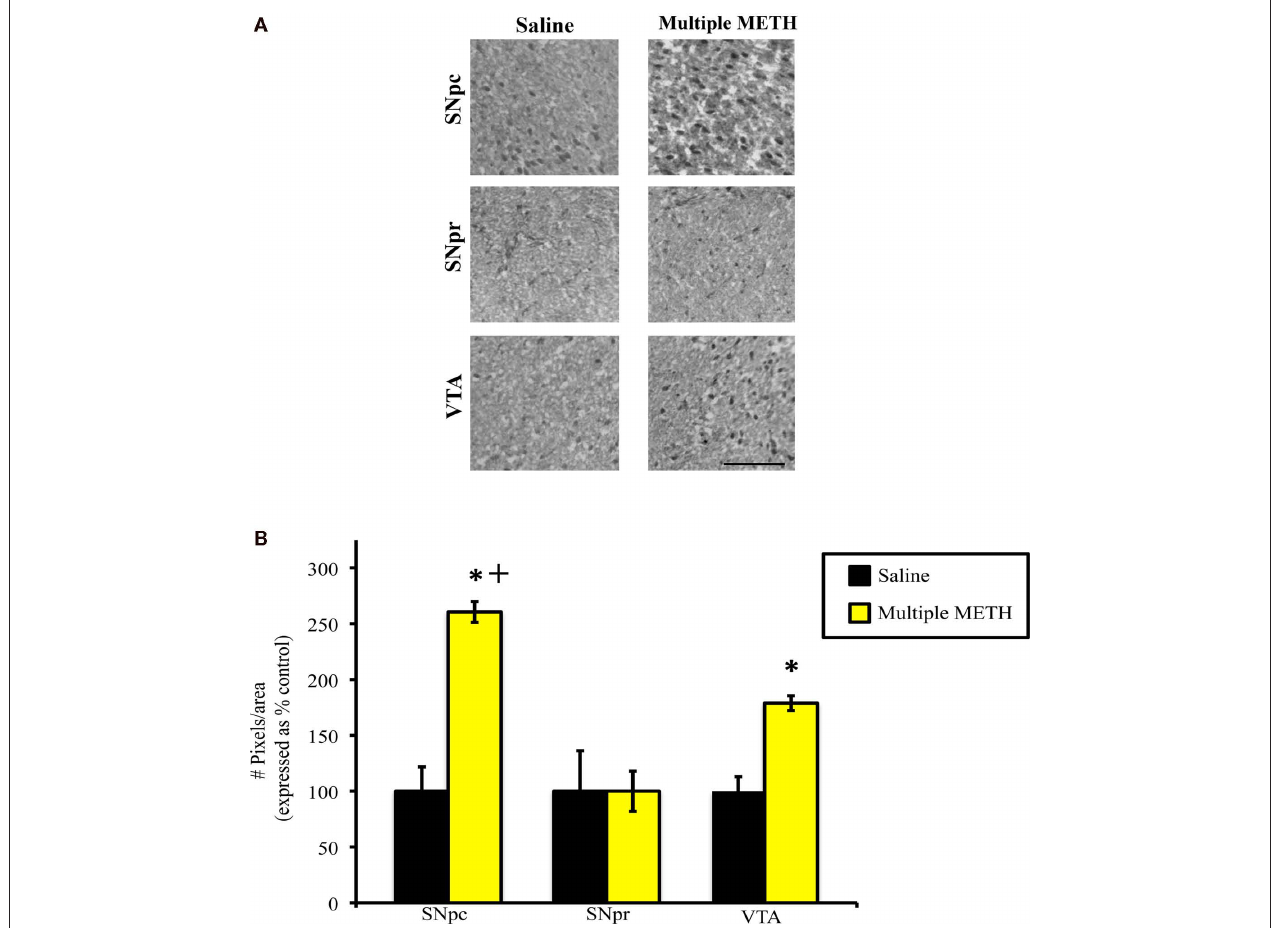
doses of METH significantly increased MDA-ir in the SNpc and VTA, but not in the SNpr (B) . Multiple METH treatment also resulted in significantly greater MDA-ir in the SNpc, as compared to the VTA. * p < 0.05 as compared to saline-treated animals. + p < 0.05 as compared to the VTA in METH-